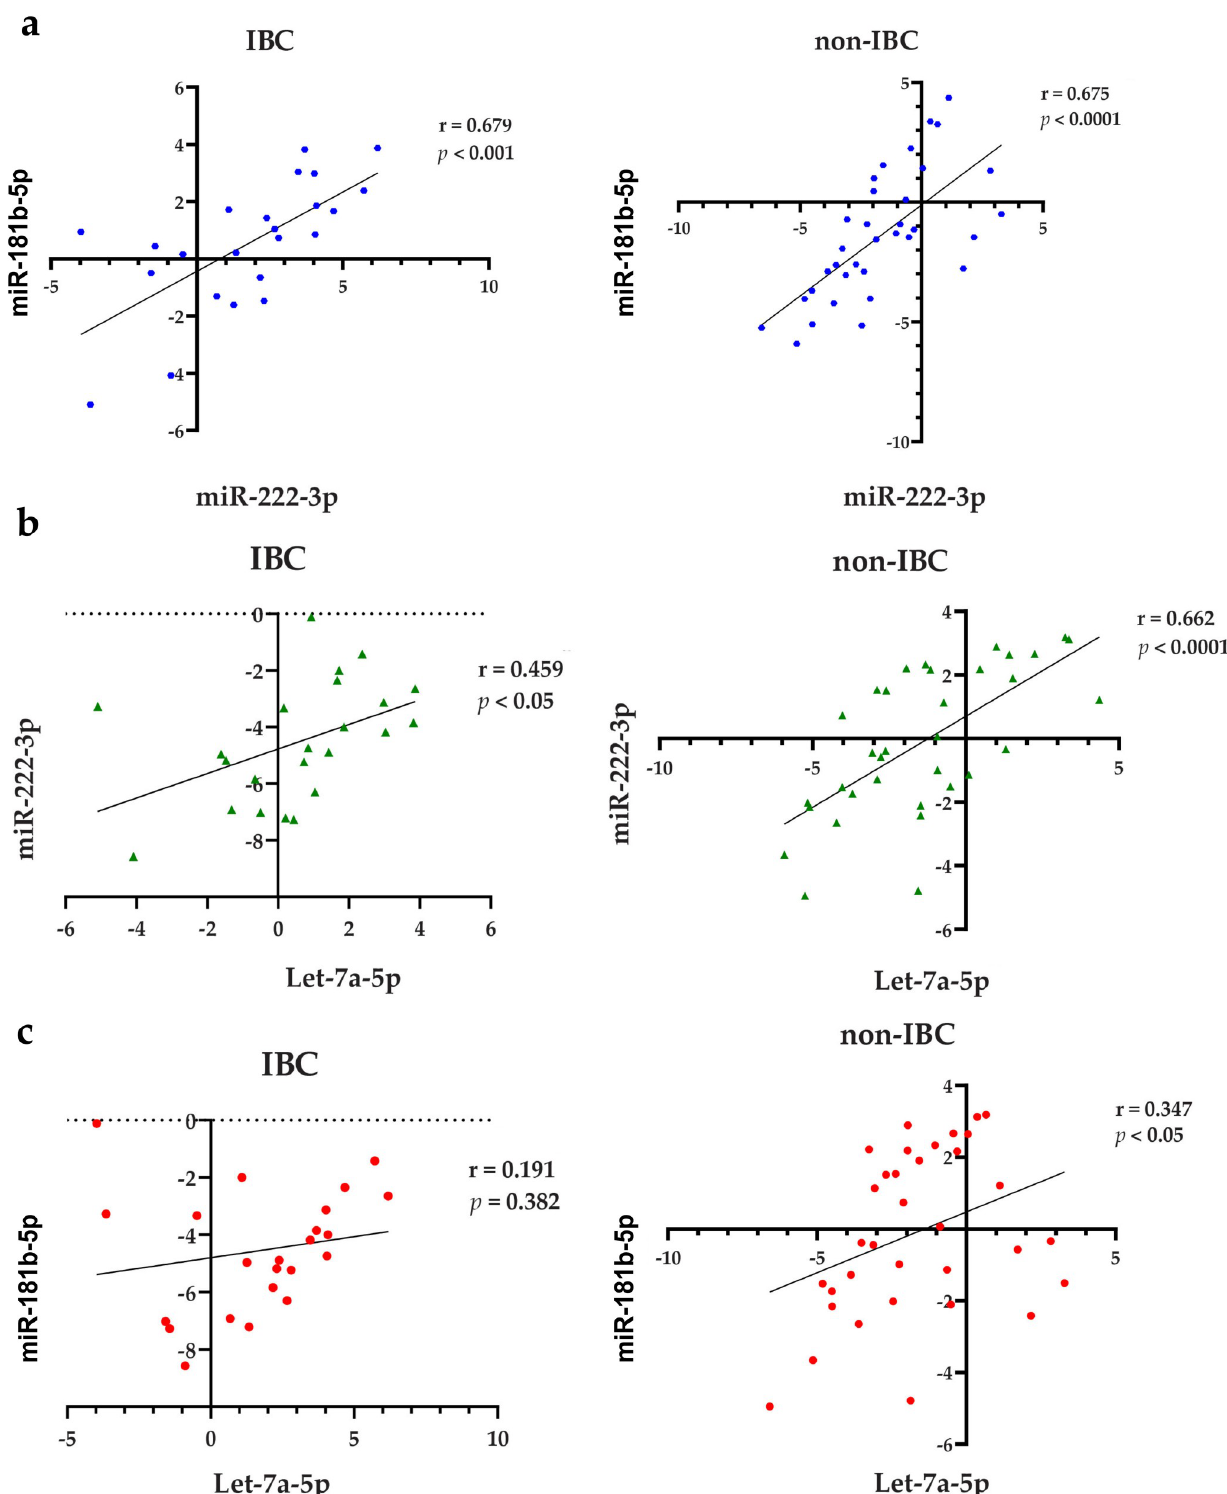
Fig 6. Pearson’s correlation analysis between miR-181b-5p, miR-222-3p, and let-7a-5p expression in sEVs. (a) A significant positive correlation between miR-181b-5p and miR-222-3p in IBC (left panel) and non-IBC (right panel). (b) A significant positive correlation between miR-222-3p and let- 7a-5p in IBC (left panel) and non-IBC (right panel). (c) A significant positive correlation between miR-181b-5p and let-7a-5p in non-IBC (right panel), but not in IBC (left panel). https://doi.org/10.1371/journal.pone.0250642.g006 PLOS ONE | https://doi.org/10.1371/journal.pone.0250642 April 26,